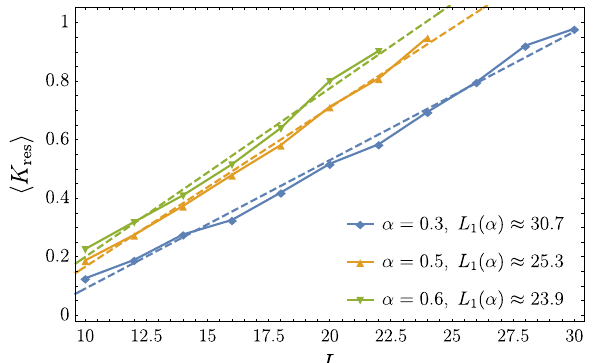
FIG. 12. The average number of resonant neighbors for an SDRG tree state in short systems. The solid lines of different colors correspond to different values of the exponent α . Dashed aL − b . For each value of lines represent linear fits, h K res i ¼ disorder, the legend also indicates the scale L 1 ð α Þ defined by h K res i ¼ 1 (see the main